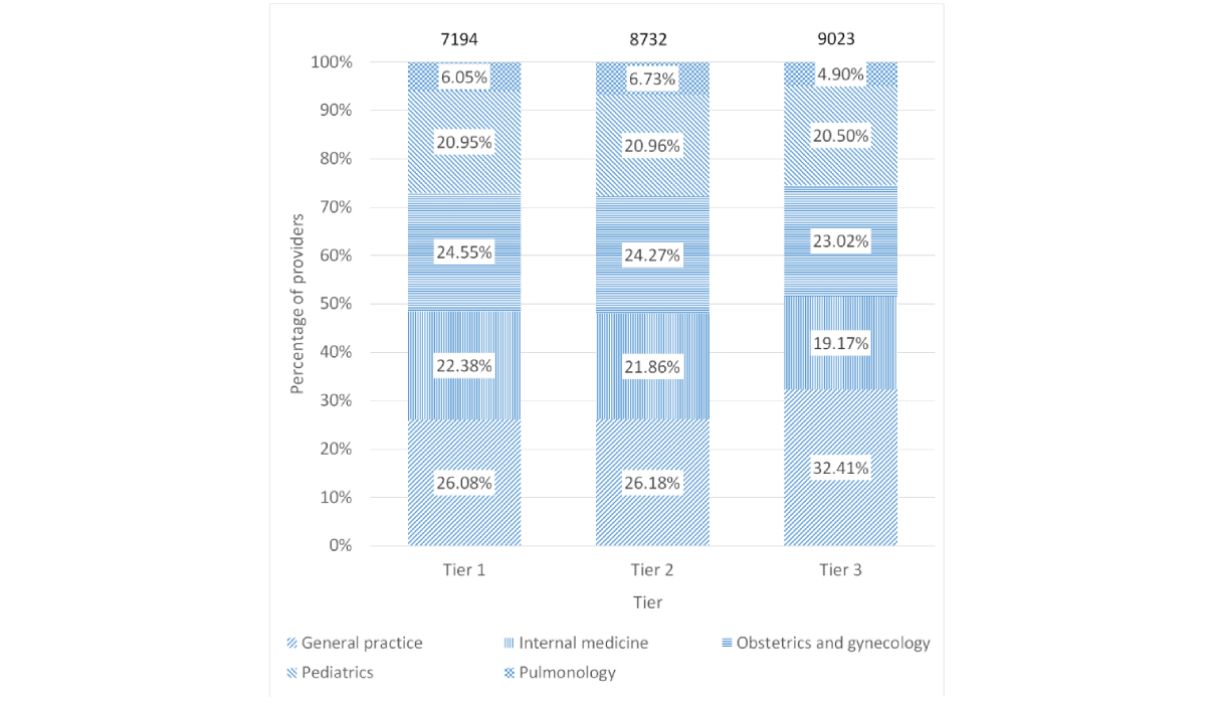
Figure 2. Provider count in the activity dataset by specialty and city